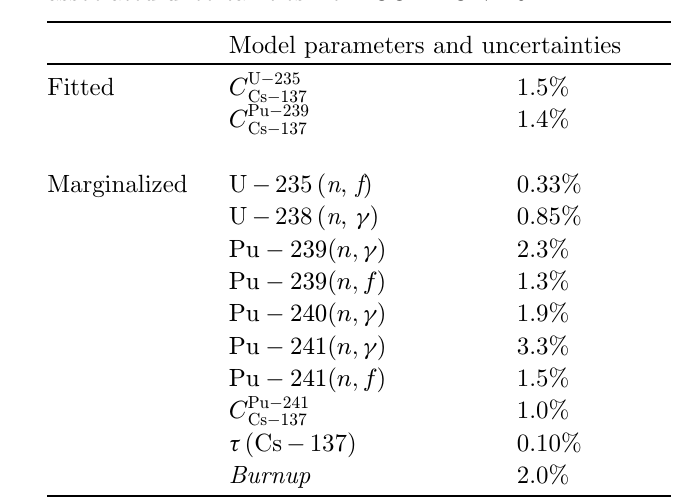
Table 2. Model parameters used for the study, and associated uncertainties from COMAC-V2.0.